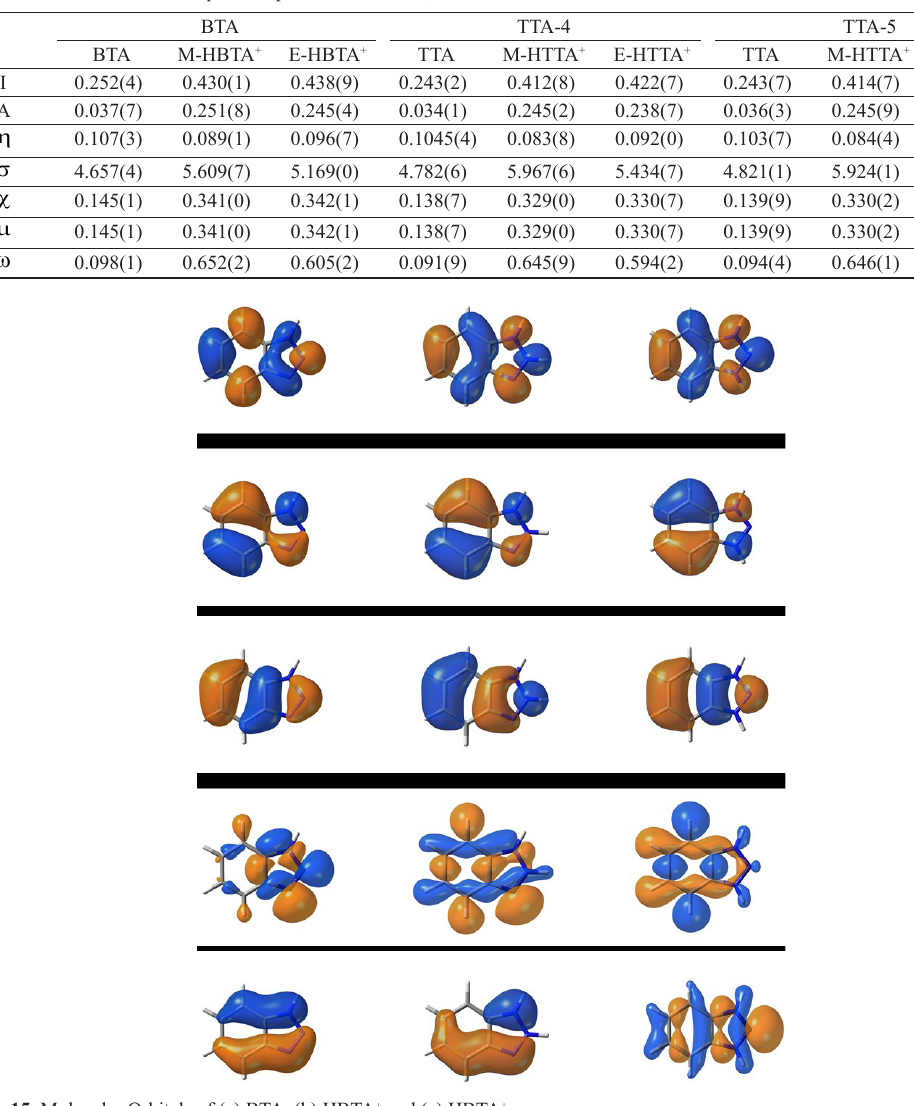
Figure 15. Molecular Orbitals of (a) BTA, (b) HBTA + and (c) HBTA +